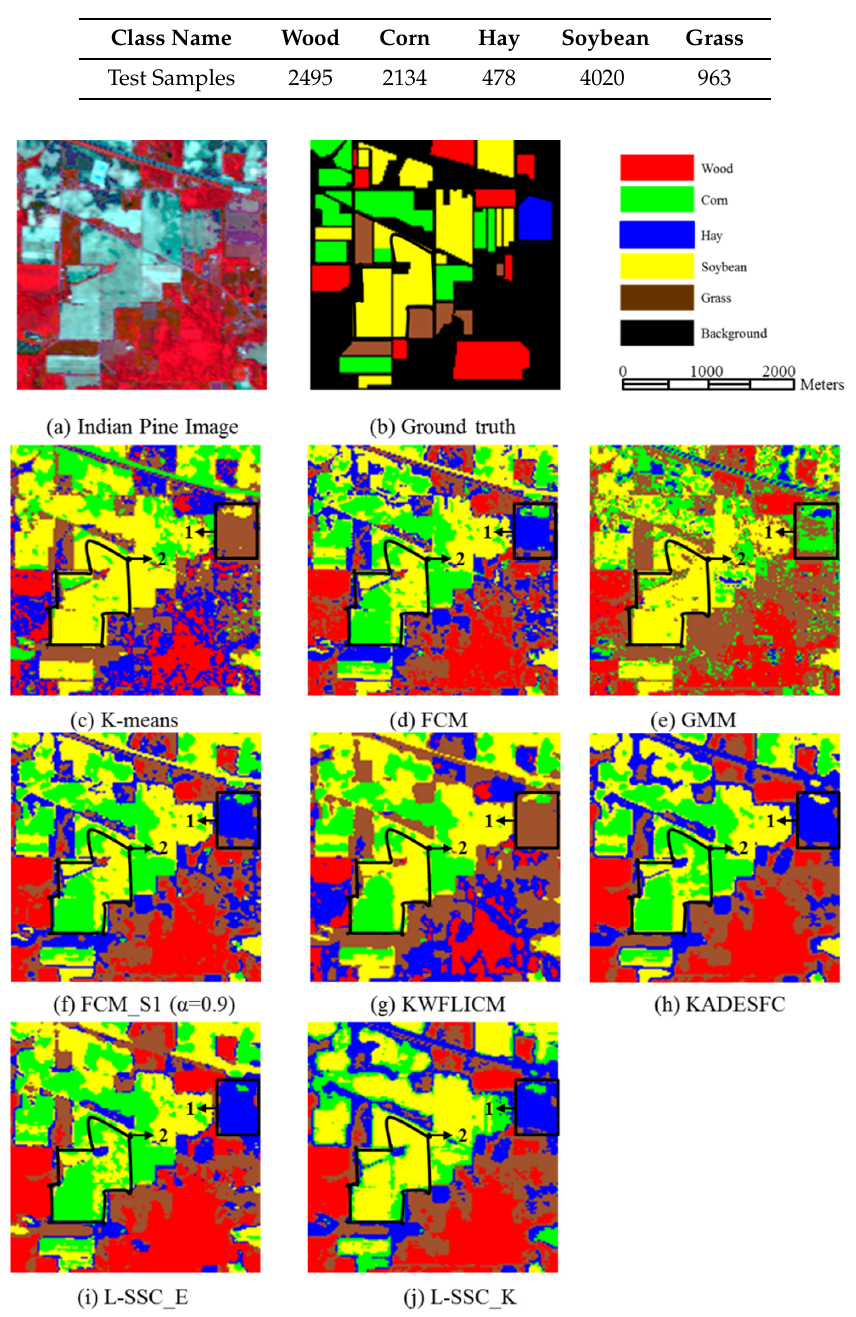
Table 5. The number of the test samples used for the Indian Pine image.